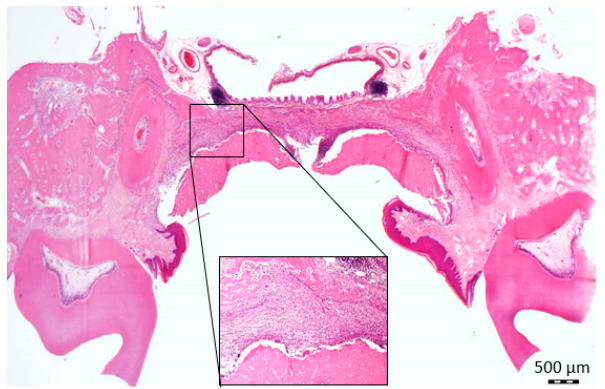
magnification ×40).